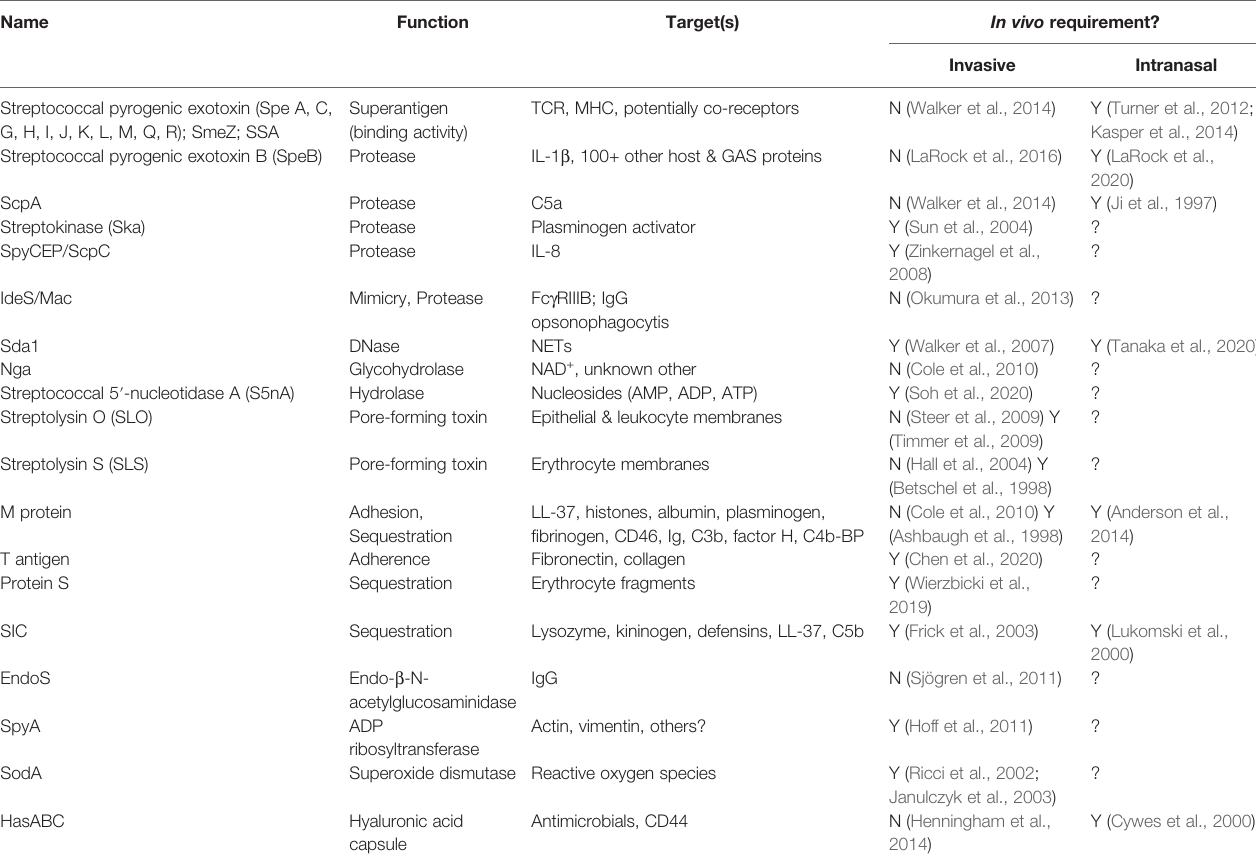
TABLE 1 | Predominant GAS virulence factors, their known mechanisms and targets, and their essentiality in models of invasive (intradermal, subcutaneous, or intravenous) or nasopharyngeal (intranasal)